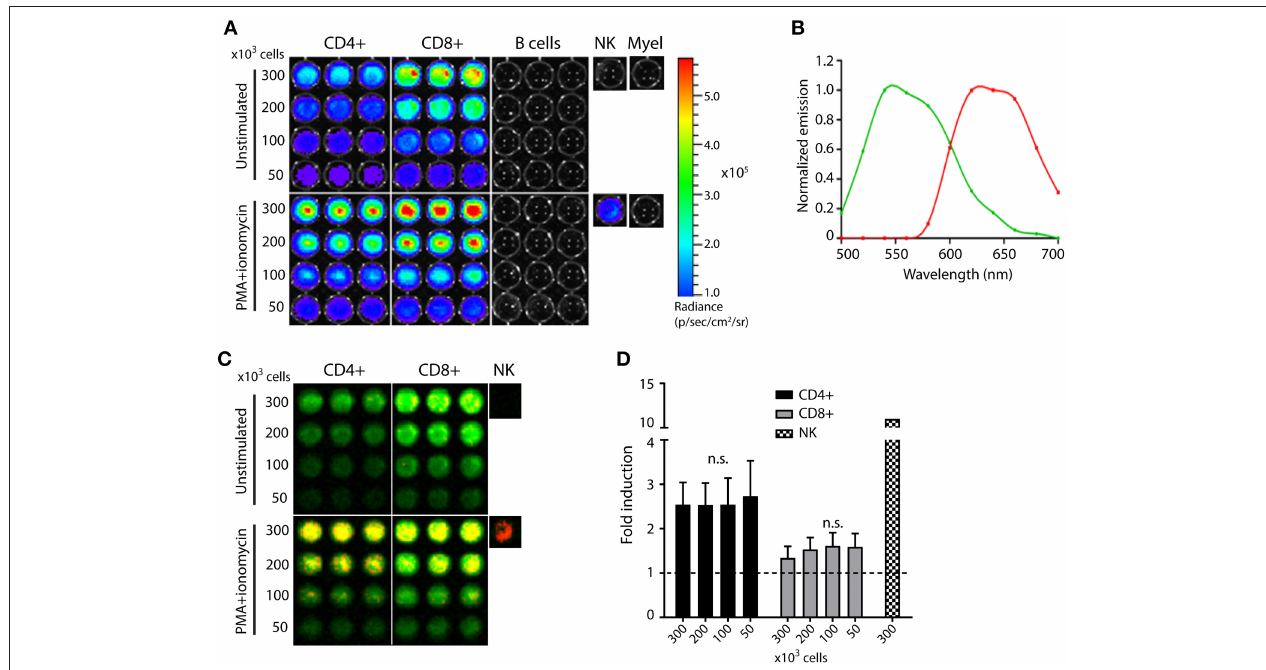
FIGURE 2 | T cell-specific expression of constitutive and inducible luciferases in the TbiLuc mouse. T cells, B cells, NK cells, and myeloid cells were isolated from the spleen of TbiLuc mice, plated in different numbers, and stimulated overnight with PMA + ionomycin to activate the NFAT-inducible red luciferase. Representative data from two independent experiments. (A) Luciferase expression is restricted to CD4 and CD8T cells and signal strength correlates to the number of T cells, both in unstimulated (top half) and PMA + ionomycin stimulated cells (bottom half). (B) Spectral unmixing of the total BLI signal identifies two emission spectra matching the constitutive CBG99 luciferase (green) and the NFAT-inducible PpyRE9 luciferase (red). (C) Spectral unmixing applied to the signals from Figure A indicates that naïve T cells express only constitutive CBG99 luciferase (top half, green color), while activated T cells express both luciferases (bottom half, overlay of green and red signals yielding yellow). NK cells produce PpyRE9 after stimulation but do not express CBG99 luciferase. (D) Fold induction of NFAT-luciferase expression in TbiLuc cells after PMA + ionomycin stimulation compared to unstimulated cells. Signals are corrected for differences in constitutive hCD2-luciferase expression. Baseline expression (1-fold) is indicated by the dotted line. Representative data of two independent experiments with n = 3 samples per group each ( n = 1 for NK cells). Mean + SD, the fold induction within a cell subset is independent of cell number as there are no significant differences within CD4T cells or within CD8T cells (one-way